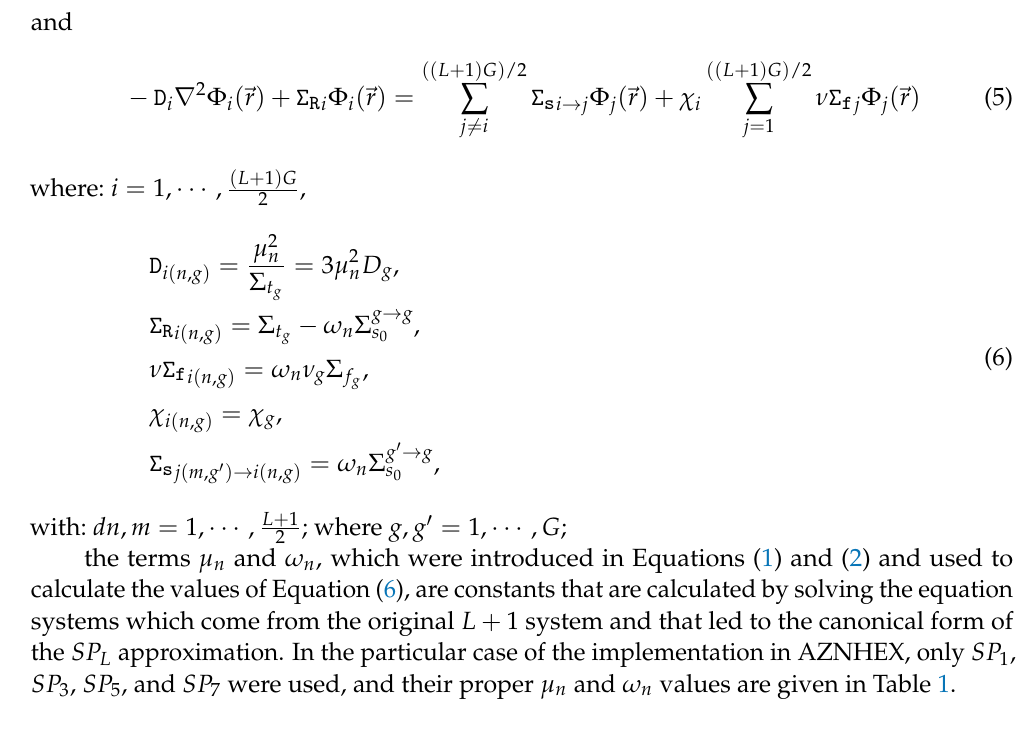
Table 1. Values of constants µ n y ω n for given SP L aproximation